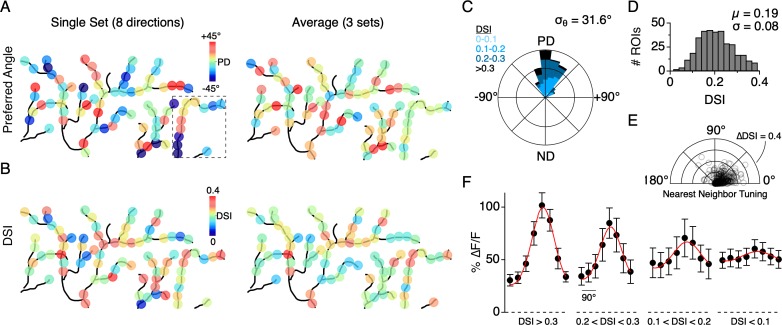
Distribution of directional tuning across the DSGC dendritic arbor.(A) Maps of the preferred angle of each dendritic ROI, as measured over a single stimulus set (left), or averaged over multiple sets (right). The boxed area denotes the region used for the analysis presented in Figure 4. (B) Same as in A, but for the DSI. (C) Rose plot showing the distribution of the average PD for ROIs across the dendritic arbors of 7 ON-OFF DSGCs, relative to the PD of each DSGC’s spiking response (angular standard deviation, σθ = 31.6°). Colors indicate the proportion of ROIs within different ranges of DSI. (D) Distribution of DSIs for all dendritic ROIs (DSI = 0.19 ± 0.08, n = 353 ROIs from 7 cells). (E) Polar plot showing the difference in the DSI and PD between each ROI and its nearest neighboring ROI. (F) Average tuning curve for dendritic ROIs within different ranges of DSI. Note the amplitude of the null responses for weakly tuned sites (DSI <0.1) are on average larger than null responses measured for the strongly tuned sites (DSI >0.3).Figure 5—source data 1.Vector angle and DSI measurements.